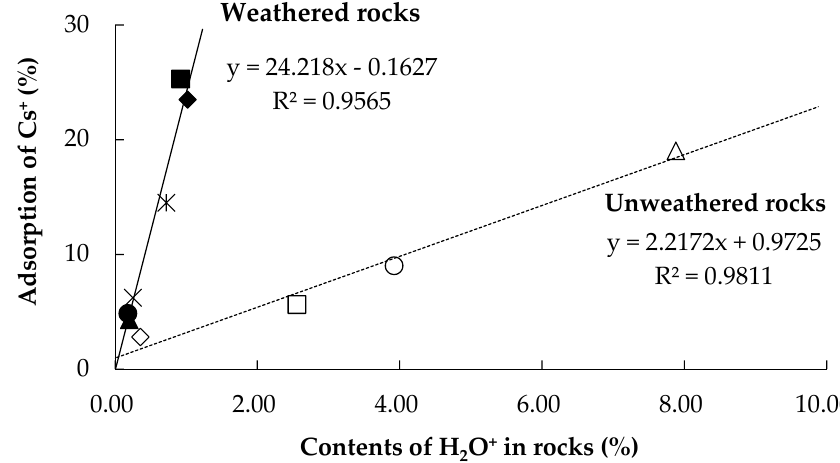
Figure 3. The correlation between the adsorption quantity for Cs + onto the natural Japanese rocks and the H 2 O + of the samples. The solid and broken lines reveal the results for unweathered (igneous rocks) and weathered (others) rocks, respectively.